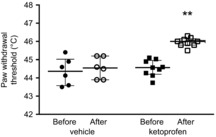
The effect on thermal paw withdrawal thresholds of acute administration of the COX inhibitor ketoprofen into the PAG, in the awake animalData are shown as individual points, lines are medians and interquartile ranges before (filled) and after (white/crosshatched) ketoprofen (n = 8) or vehicle (n = 6) administration into the PAG (Kruskal–Wallis statistic = 18.45, P = 0.0004 followed by post hoc Dunn's tests, **P < 0.01, compared to both before ketoprofen and after vehicle).